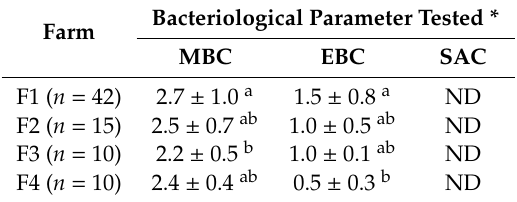
Table 4. Bacteriological quality of udder surface samples according to the